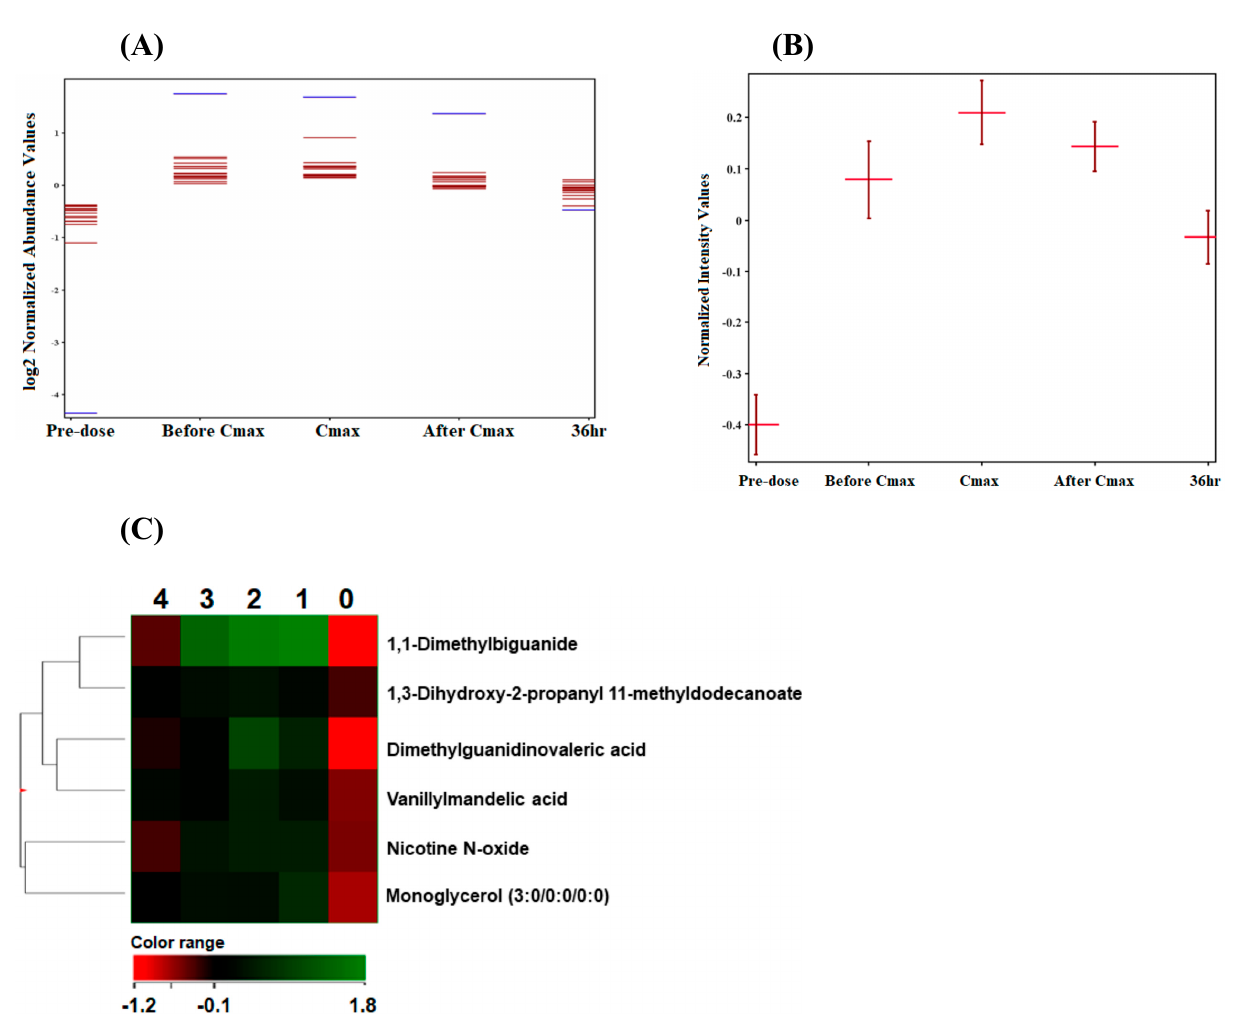
Figure 4. ( A ) Metformin-dependent lipids and metabolites with similar kinetics to metformin. ( B ) Example of the metformin dependent lipid, 1,3-Dihydroxy-2-propanyl 11-methyldodecanoate, showing similar change in its level as metformin. ( C ) Hierarchal clustering (HAC) and heatmap analysis of five metformin-dependent biomolecules showing similar changes in their level to metformin. Time points 0, 1, 2, 3, and 4 refer to predose, before C max , C max , after C max and 36 h post-metformin administration. Metformin is 1,1-Dimethylbiguanide. Lipids with opposed levels to metformin patterns included fatty acyls (fatty esters, fatty acids, and eicosanoids), sterol lipids, glycerolipids, and glycerophospholipids (glyc- erophosphocholines,